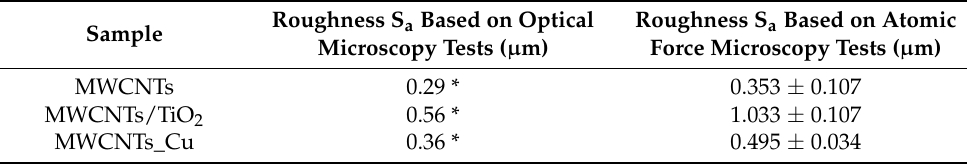
Figure 1. Surface topography based on optical microscopy tests for ( A ) the MWCNTs coating, ( B ) the MWCNTs/TiO 2 coating, and ( C ) the MWCNTs_Cu coating. Table 2. Surface roughness of the deposited coatings.